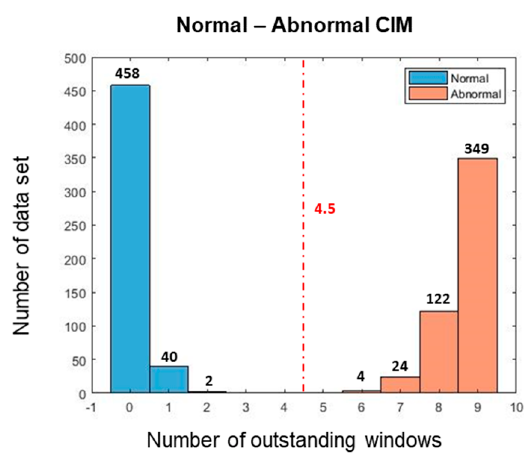
Figure 16. Number of OWs for classification in bearing case: normal vs. abnormal. Table 4. Comparison of confusion matrices between CIM approach and 1D CNN approach.